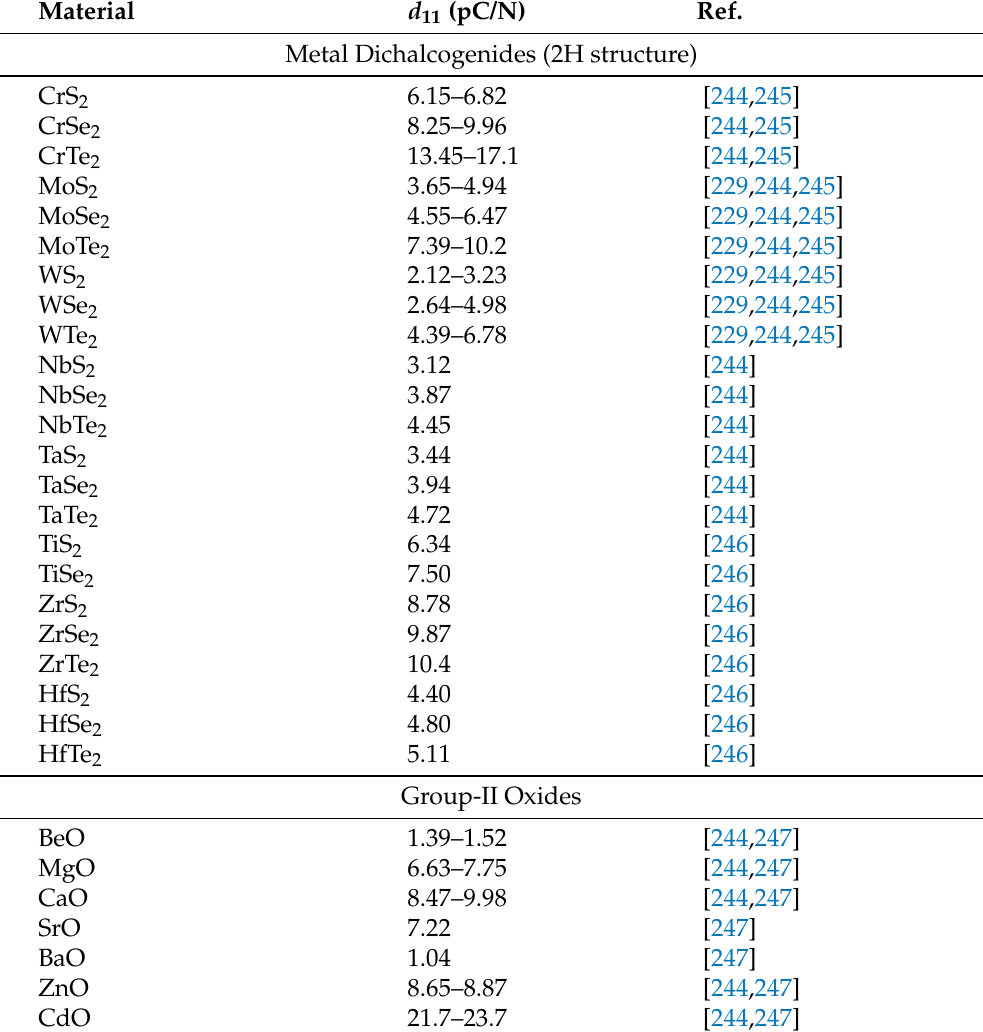
Table 6. Comparison of piezoelectric coefficient for 2D